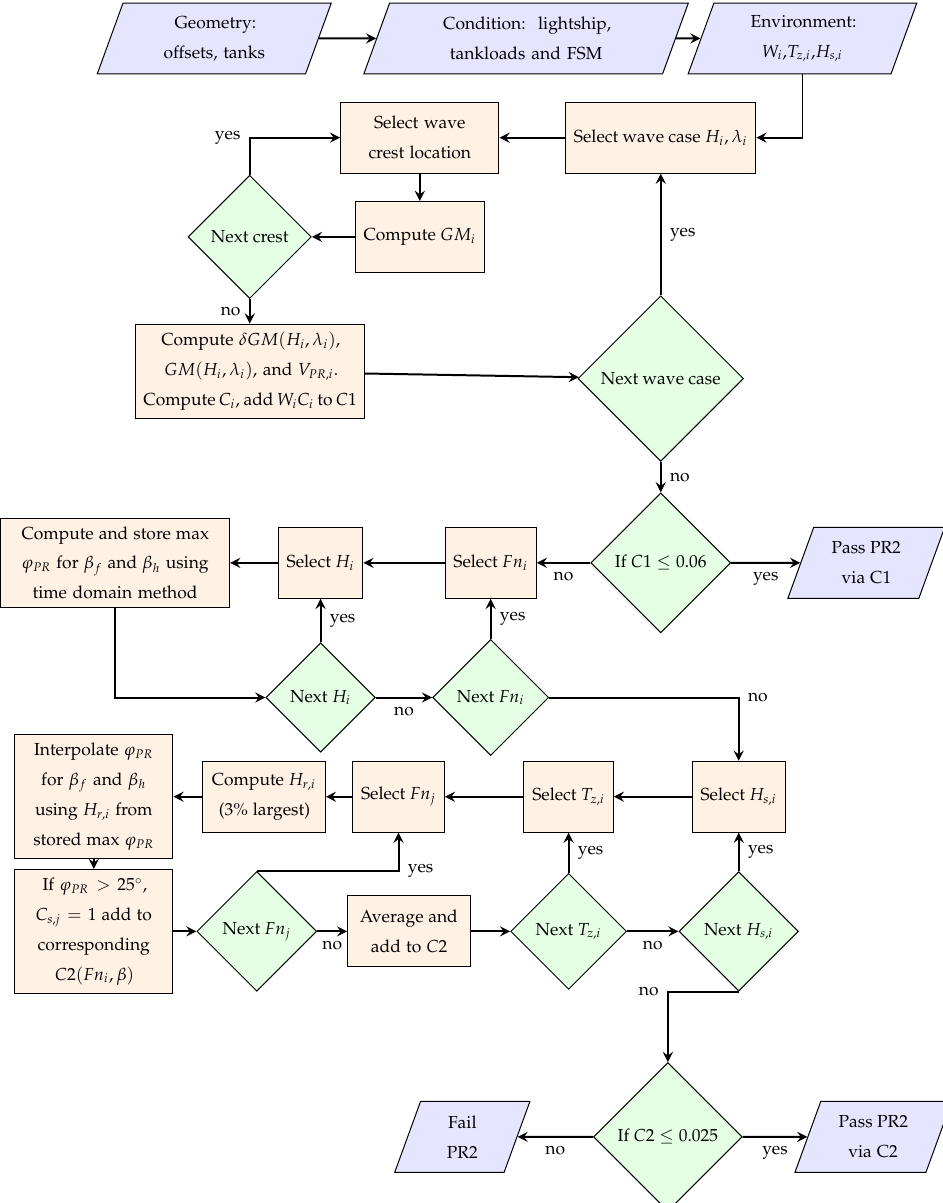
Figure 13. Parametric roll level 2 algorithm process